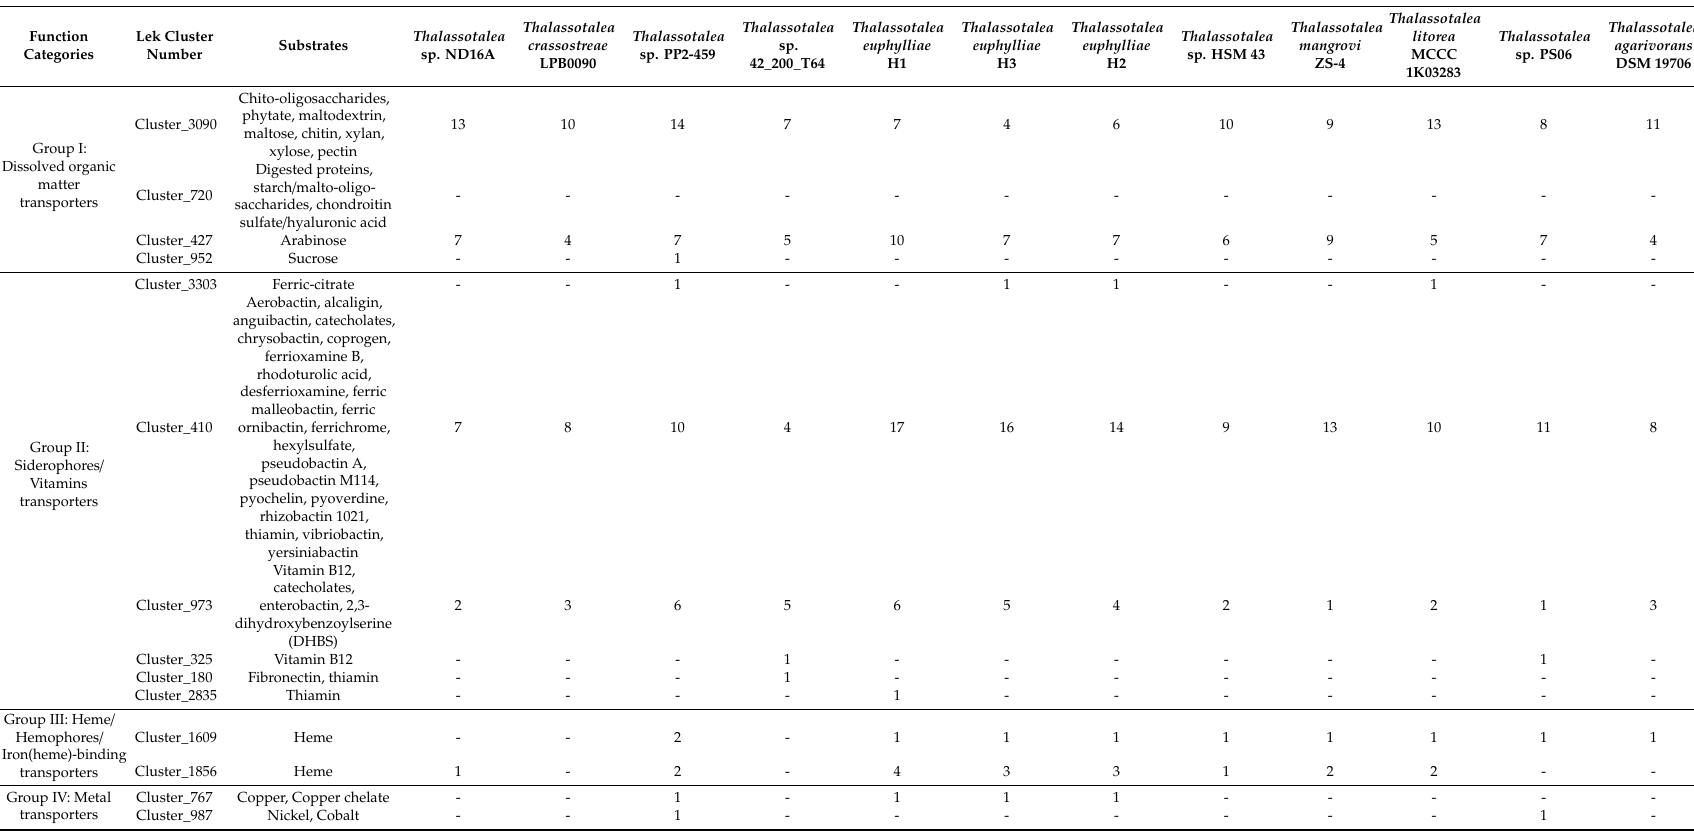
Table 1. Summary of genes encoding TonB-dependent transporters (TBDTs) in Thalassotalea genomes. TBDTs are classified based on Tang et al. [37]. Function